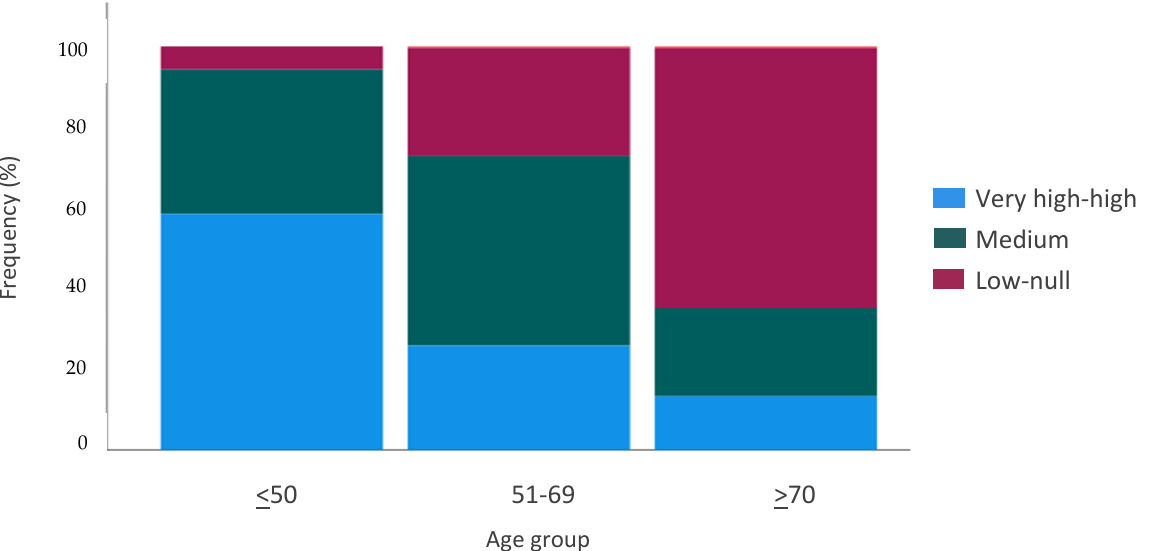
9 Figure 5. Preferences for the type of information given during a telemedicine visit. All patients. Q6– Q9. Would you agree to be informed via telemedicine of…? 3.3. Patients’ Knowledge of New Technologies Patients were asked about their abilities with new technologies ( Q11: What is your knowledge of new technologies? ) and the tools they would prefer to use to contact health professionals ( Q12: Which tool would you like to use to reach your oncologist? ). For the first question, we observed that the familiarity of the study population with